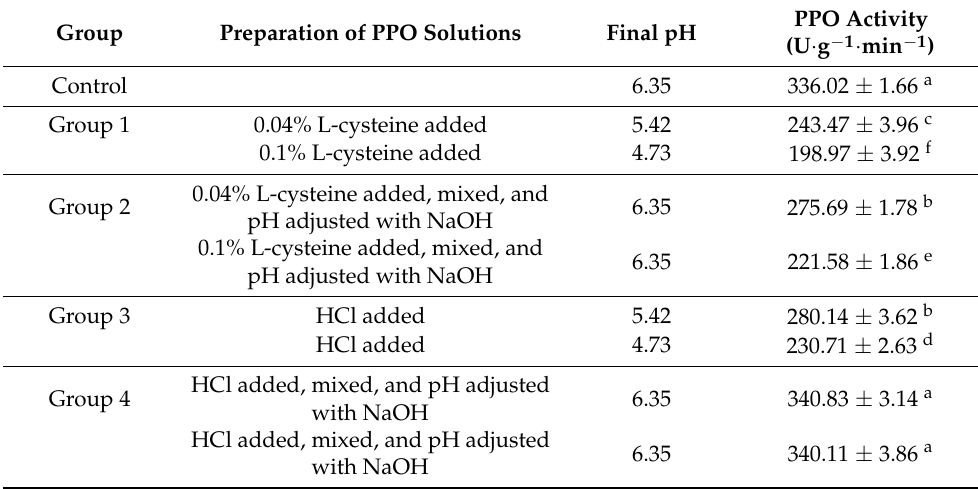
Table 2. pH value and PPO activities of PPO